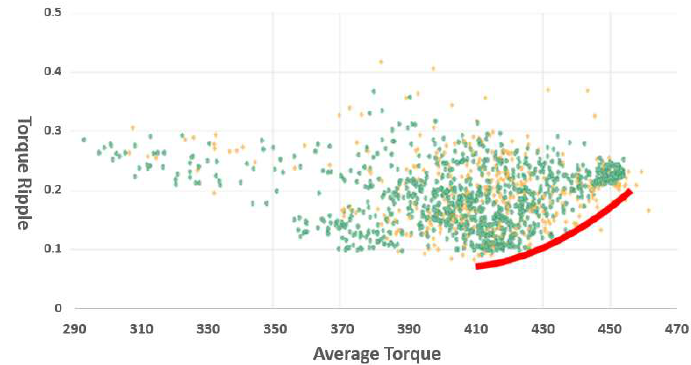
Figure 13. Average torque-torque ripple pareto front.